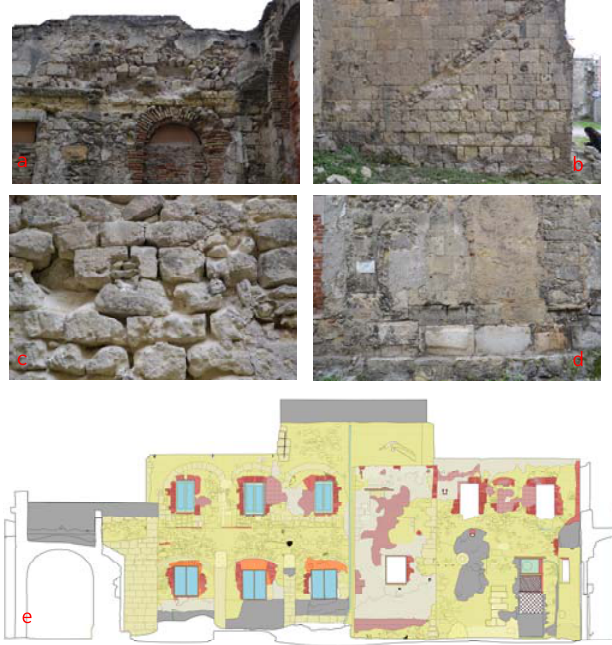
Figure 8: Stone materials used in the building: a), b), c) walls built in “pietra cantone” ashlar and rubble; d) “pietra forte” bossed blocks; e) the north facade with the mapping of materials (yellow “pietra cantone”, grey “plaster”, red “solid brick”, orange “hollow brick”, pink